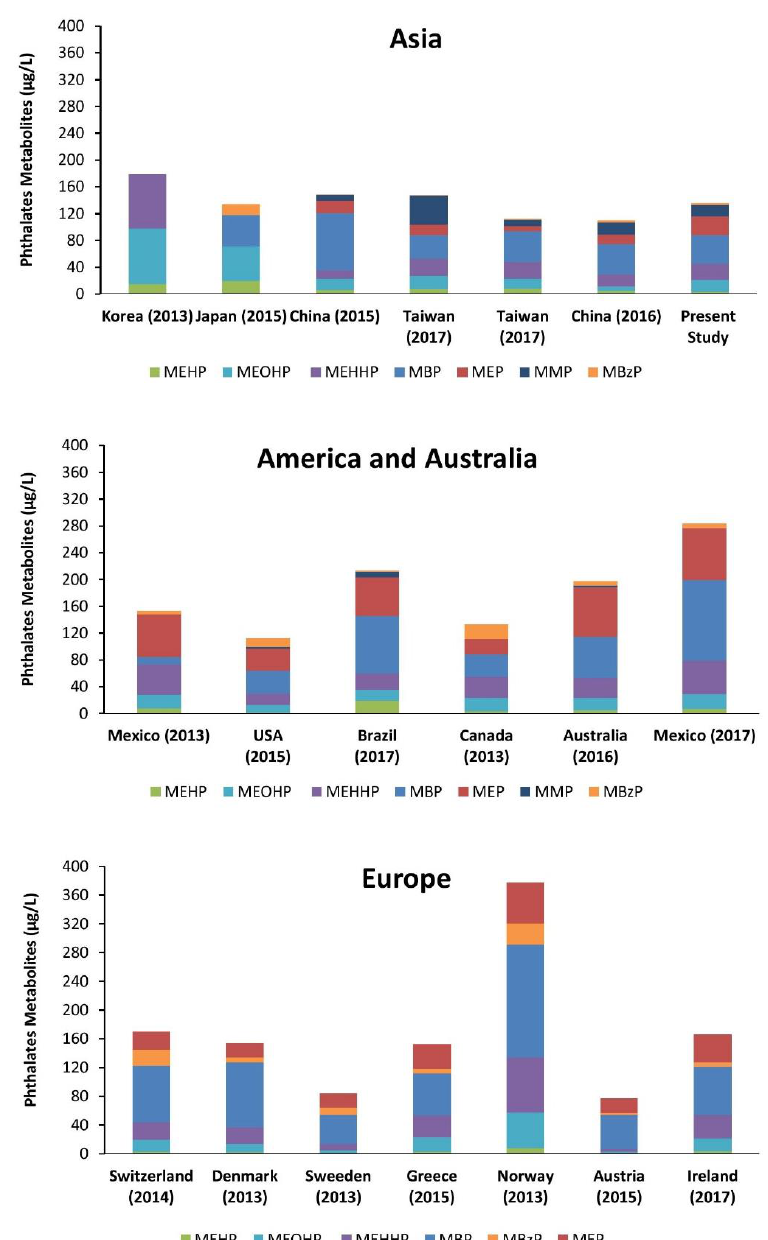
Figure 3. Median urinary concentrations (µg/L) of phthalate metabolites throughout the